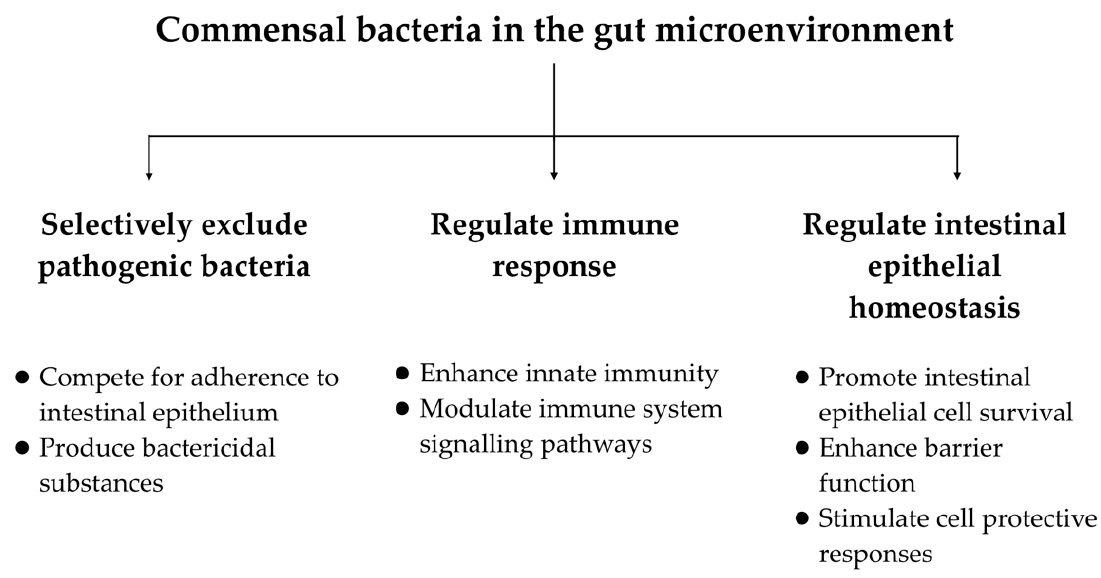
Figure 1. Proposed functions of gut commensal bacteria that may be beneficial in the prevention and treatment of colorectal cancer.